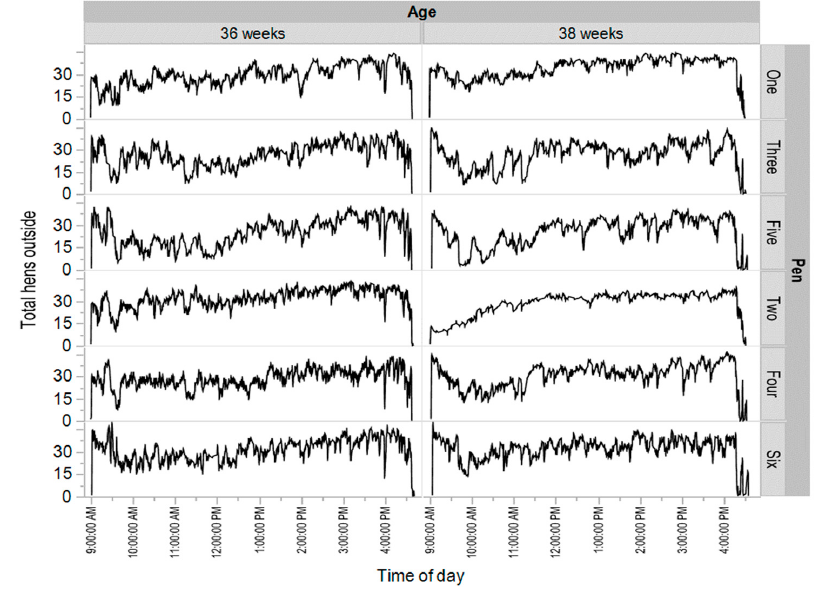
Figure 7. Number of hens outside after each hen movement indoors or outdoors across two days at the start of 36 and 38 weeks of age for each pen of birds (pens one, three and five were from the enriched rearing treatment and pens two, four and six were from the non-enriched rearing treatment). Table 2. Mean number (±SEM) of pairs of hens detected as possible social pairs moving in or out with a median separation distance of no more than 8 or 9 hens in between 1 . Data 9 Hens 8 Hens